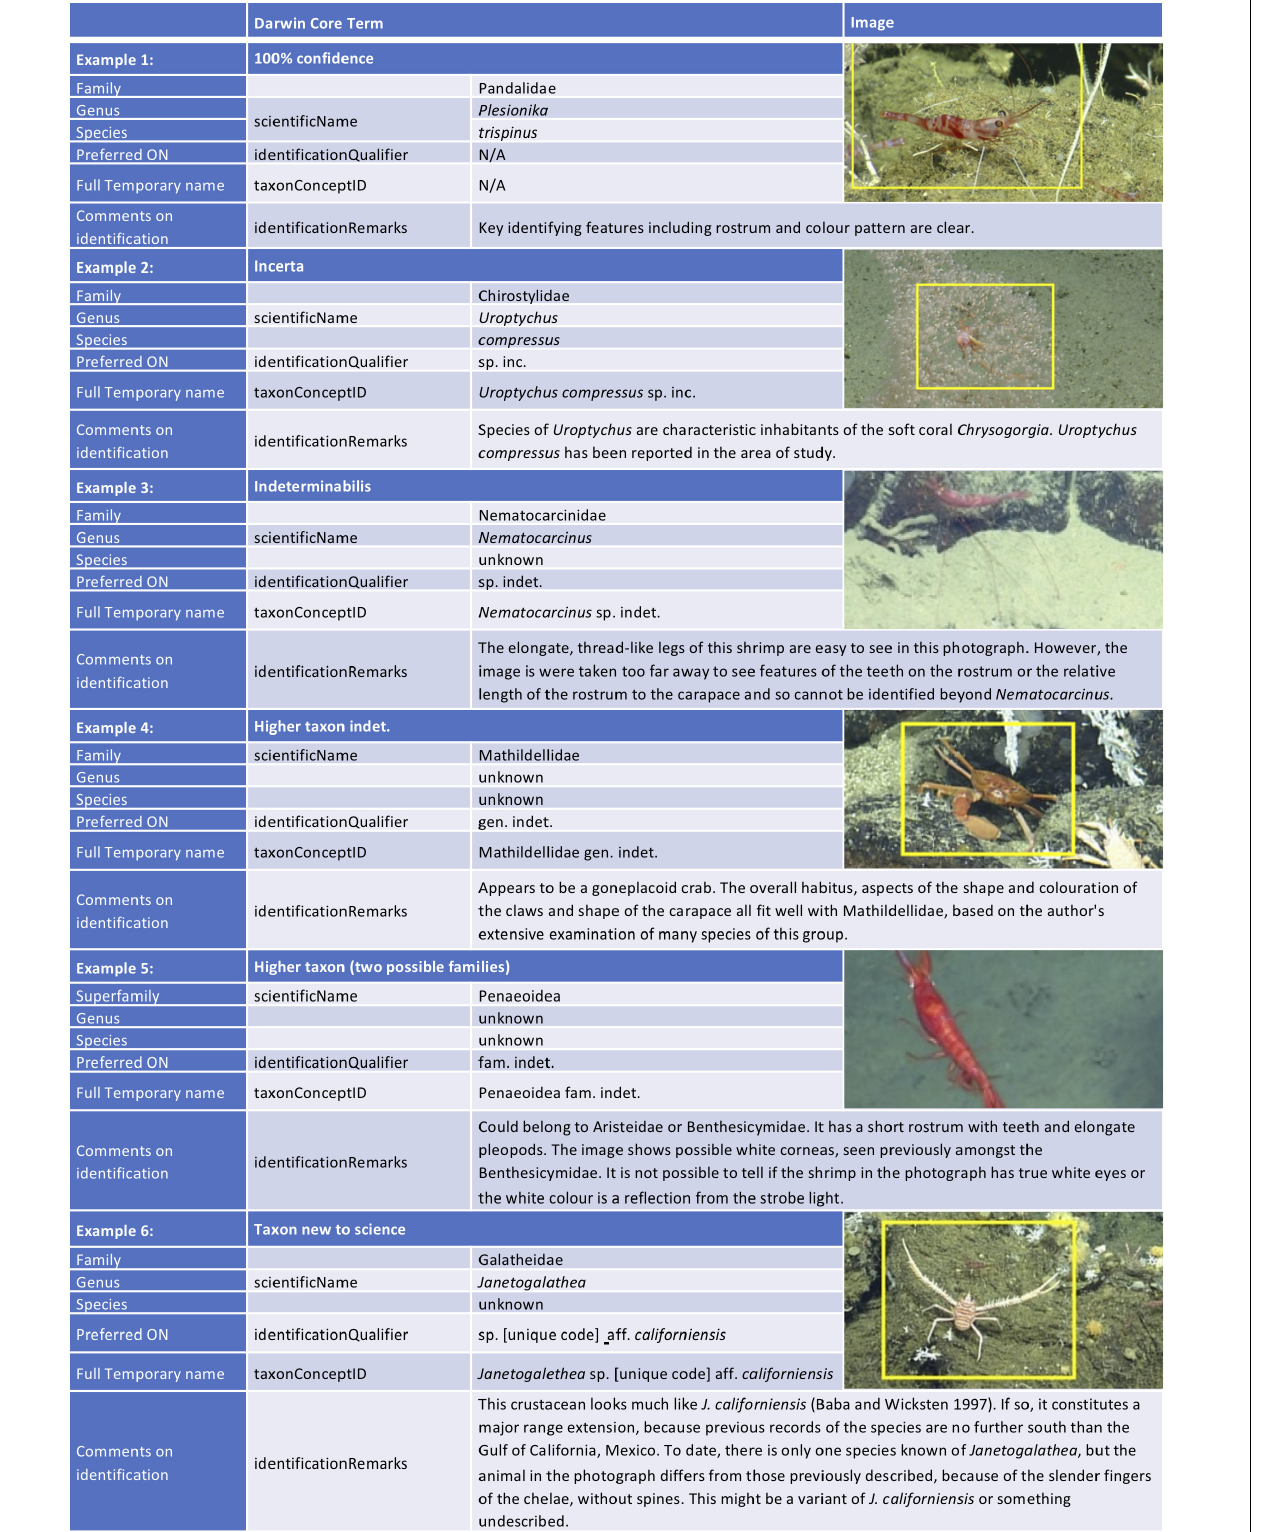
Frontiers in Marine Science |